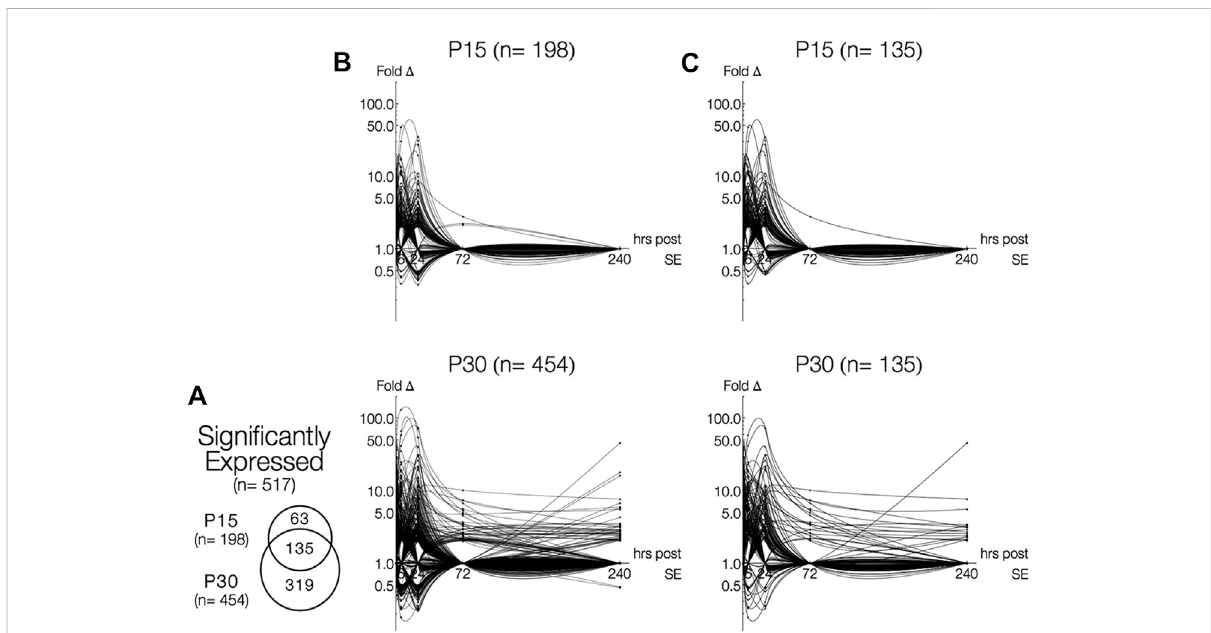
FIGURE 1 Time-and age-dependent gene regulation in rat hippocampus after KA-SE. (A) Venn Diagrams of all differentially expressed genes (fold change > 2, p < 0.05, q < 0.05). While majority of genes (135/198, 68%) in P15 are also expressed in P30, many genes (319/454, 70%) are expressed only in P30. (B) Log-linear plots of differential gene expression (fold change) of all signi fi cant genes 1 – 240 h after KA. Data points are indicated by blackcircles.Lines,eachrepresentingasinglegene,were fi ttedusingsecondorderinterpolationforeaseofvisualization. (C) Log-linearplotsof differential gene expression of common genes between P15 and